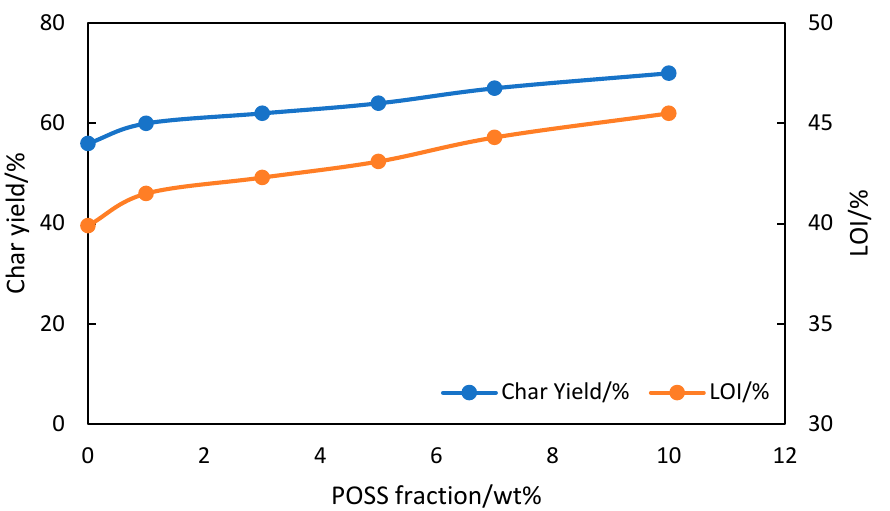
Figure 14. Dependence of char yield and LOI for phosphazene/POSS polyimide composites on wt.% POSS [192].